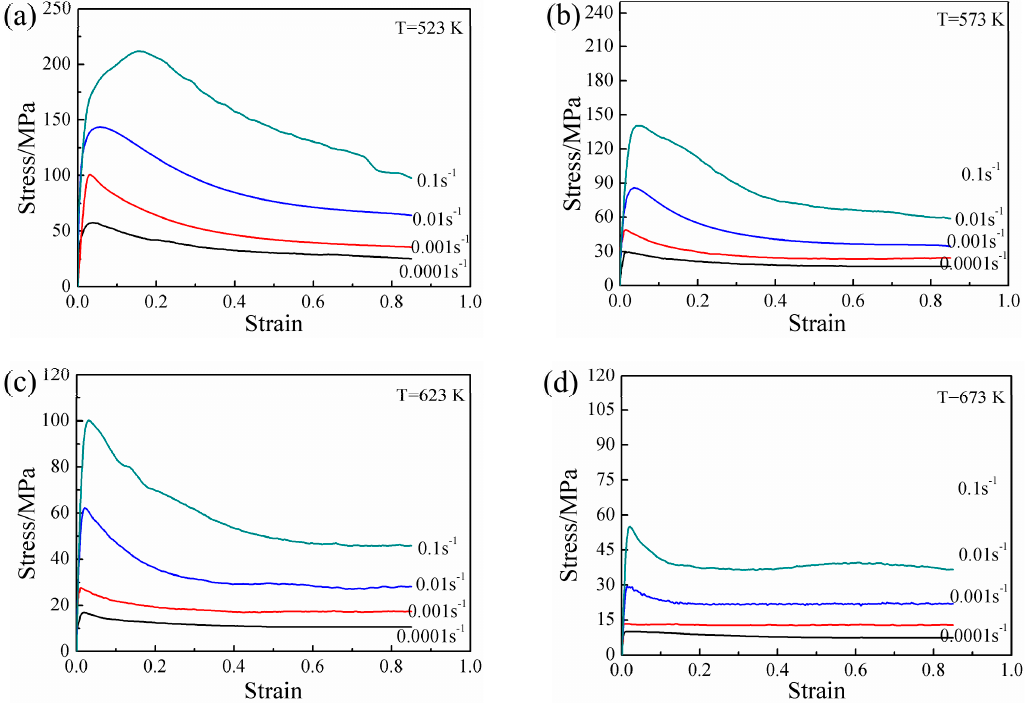
Figure 5. True stress–strain behavior of experimental alloy obtained by hot compression tests at different temperatures: ( a ) 523 K, ( b ) 573 K, ( c ) 623 K, and ( d ) 673 K.